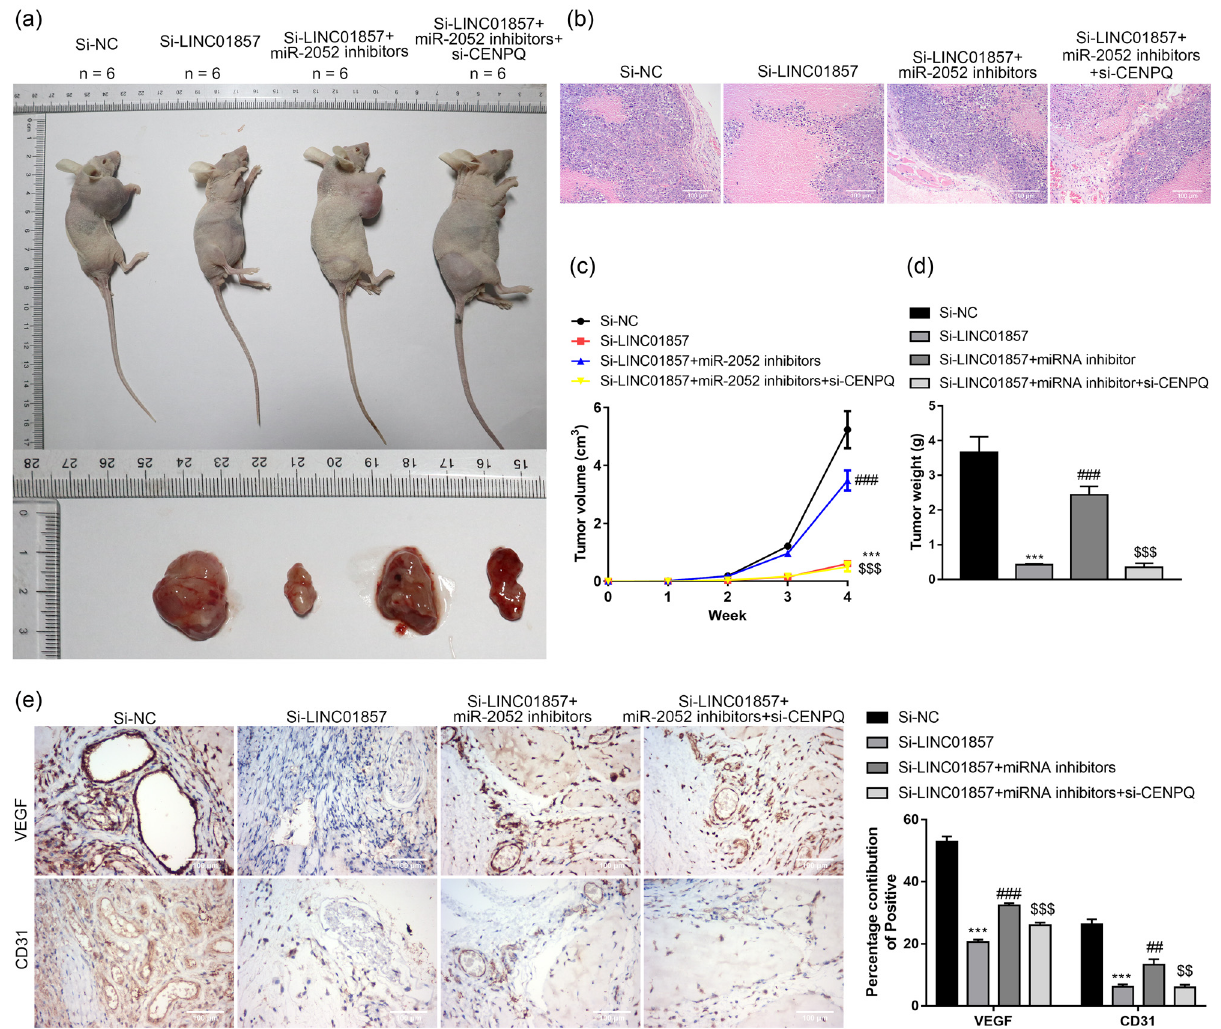
Figure 6: LINC01857 down - regulation inhibits BC tumor growth in vivo : ( a ) the representative pictures of mice and tumor tissues are shown ( n = 6 ) ; ( b ) histological changes of tumors from each group were determined by HE staining; ( c ) the volumes and ( d ) weight of tumors from each group were determined; ( e ) the protein expressions of VEGF and CD31 in tumors from each group were detected by immunohisto - chemical analysis. *** P < 0.001 vs si - NC group, ### P < 0.001 vs si - LINC01857 group, and $$$ P < 0.001 vs si - LINC01857 + miR - 2052 inhibitor